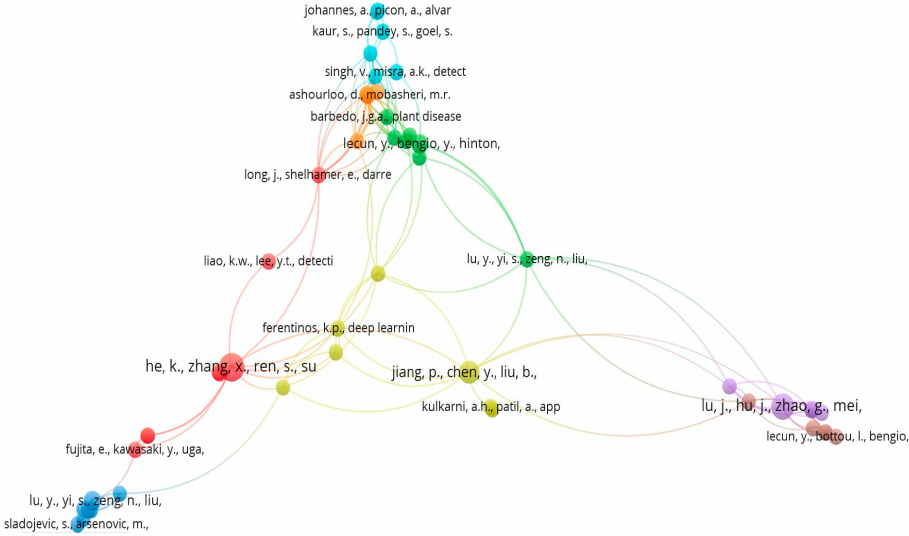
Figure 26. Reference Wise Co-citation Analysis Network (Source: https://www.vosviewer.com (accessed on 14 September 2022)).